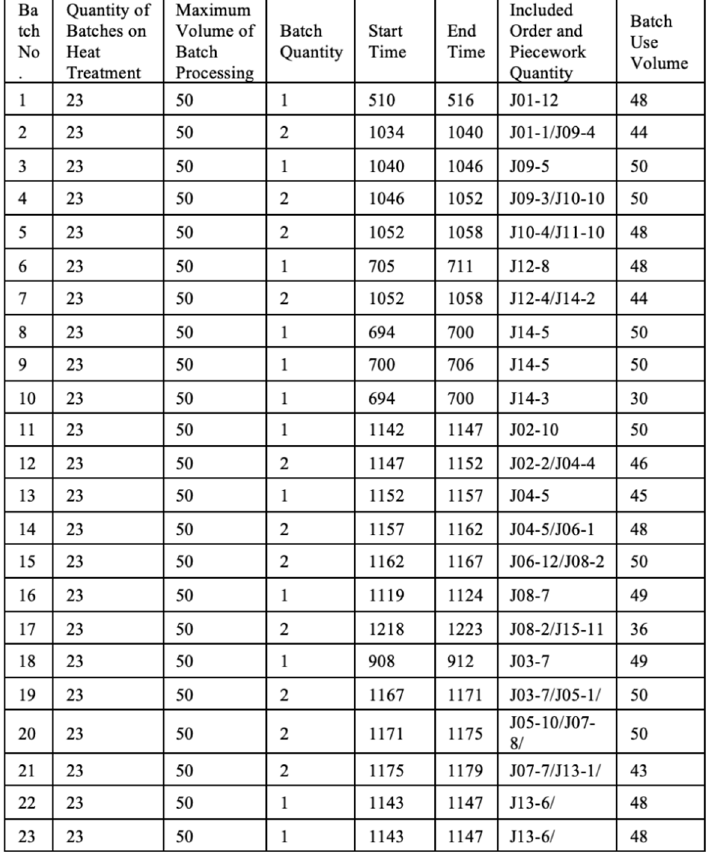
Figure 12. Heat Treatment Batches on the Heat Treatment Equipment corresponding to MK3 .